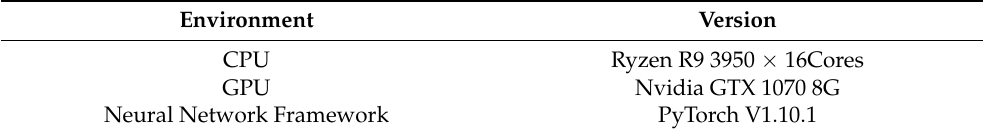
Table 3. Training environment.